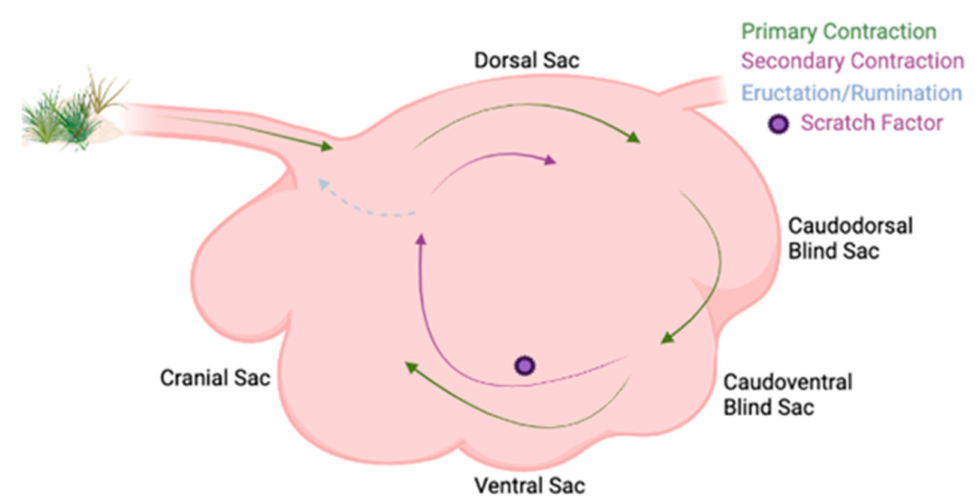
Figure 2. Ruminal contraction cycles in a labeled rumen. Labeled rumen sacs with ruminal con- tractions shown. The primary contraction cycle is shown with the green arrows in the clockwise cycle and it follows within the rumen. The secondary contraction cycle is shown with the purple arrows and is not explicitly explained in the text, but is where eructation, rumination, and continual fermentation occur, and the feedstuffs are not passed onto the